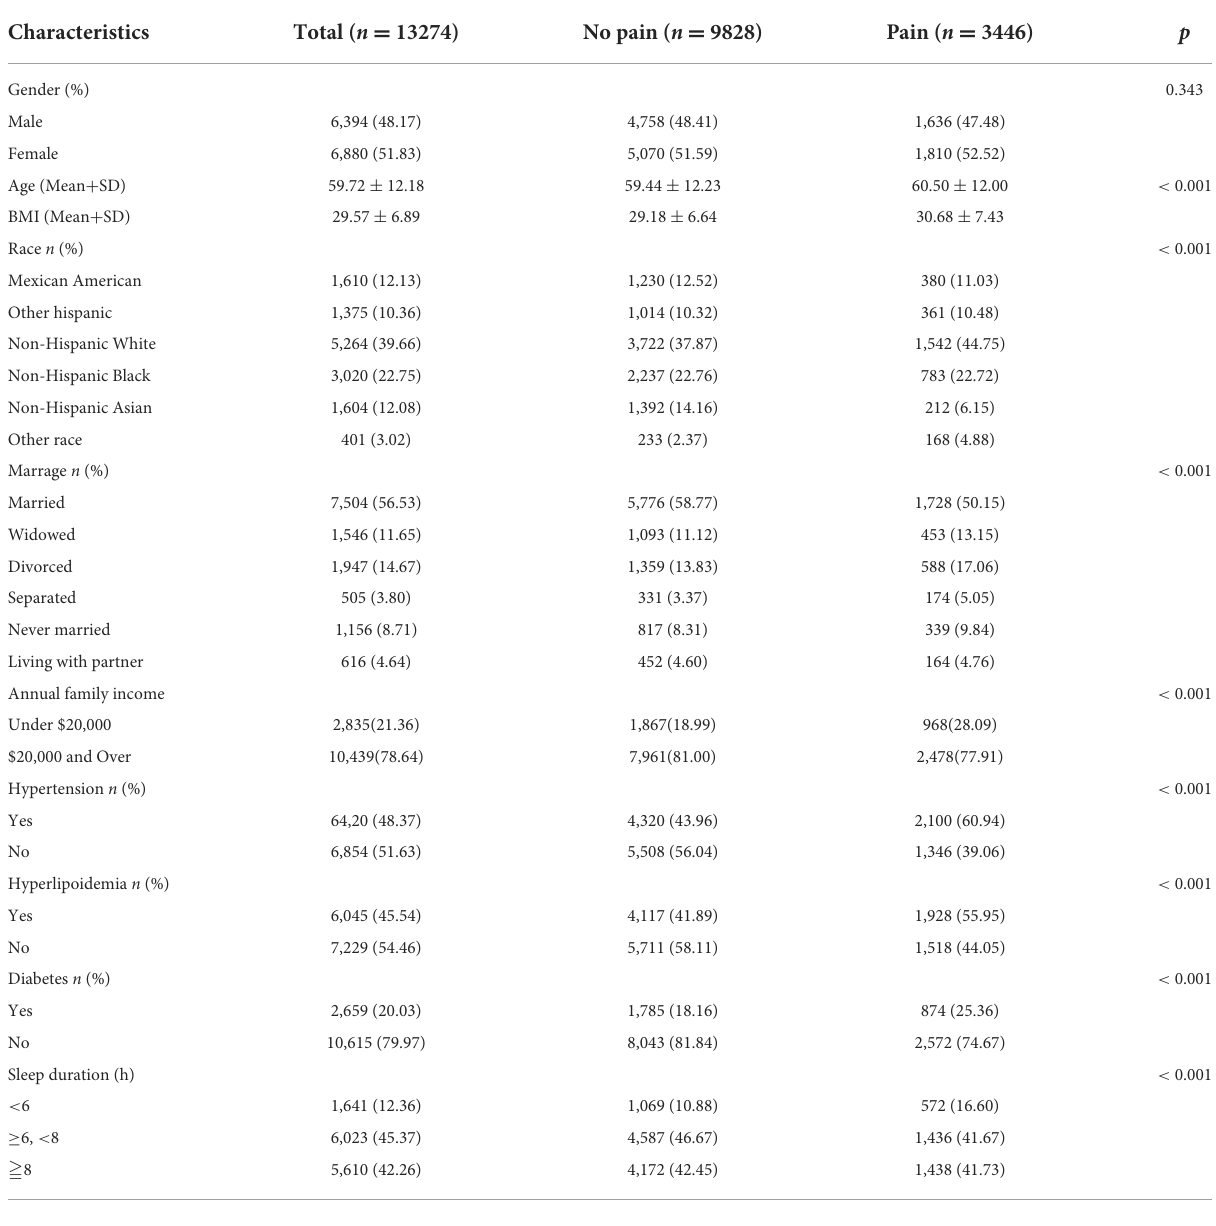
TABLE 1 Baseline characteristics of the study participants.